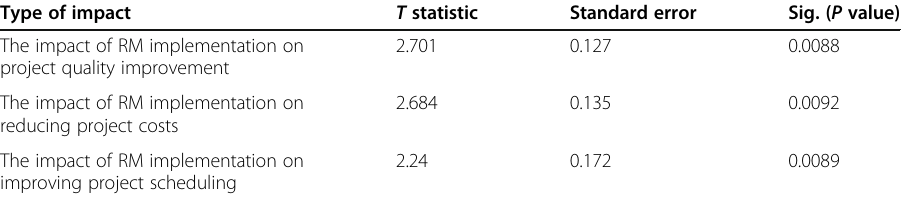
Table 10 The regression test ( P value) of RM implementation impact on projects performance Type of